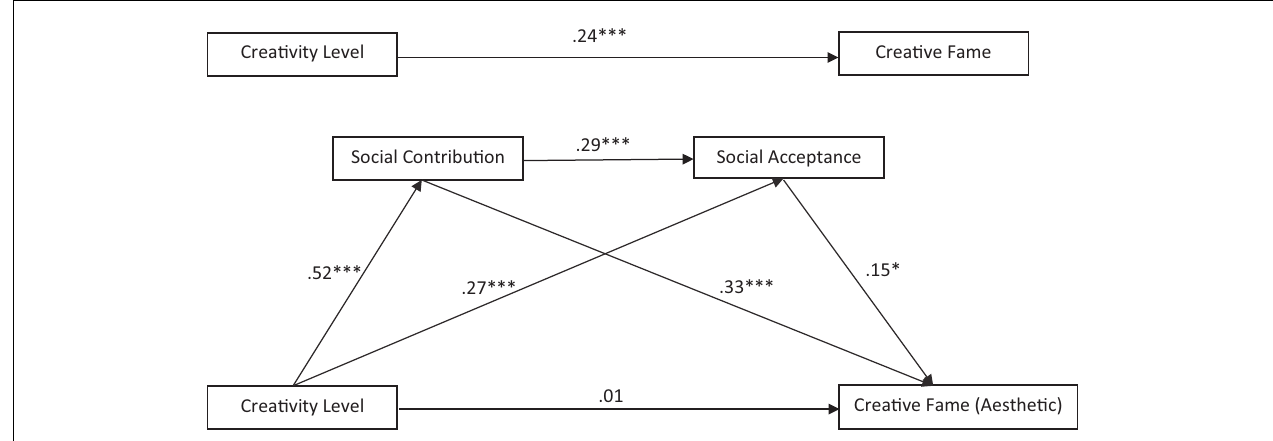
FIGURE 3 | Three-path mediation model between creativity, SC, SA and creative fame: aesthetic areas. ∗ p < 0.05, ∗∗∗ p < 0.001